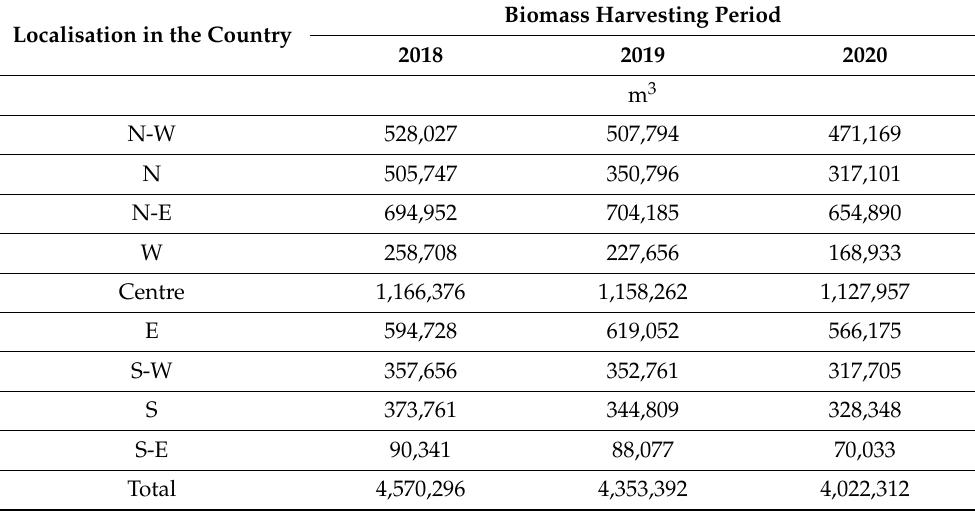
Biomass Harvesting Period